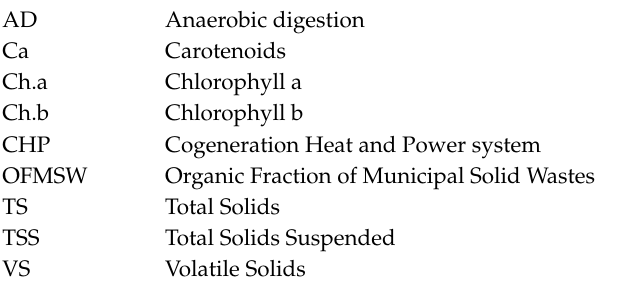
Figure S1: Cultivation of Monoraphidium sp. in batch at di ff erent concentrations, from left to right 1:20, 1:30, 1:50 respectively; Figure S2: Cultivation of Monoraphidium sp. in photobioreactors of 110 dm 3 in batch / semi-continuous regimes with digestate diluted at